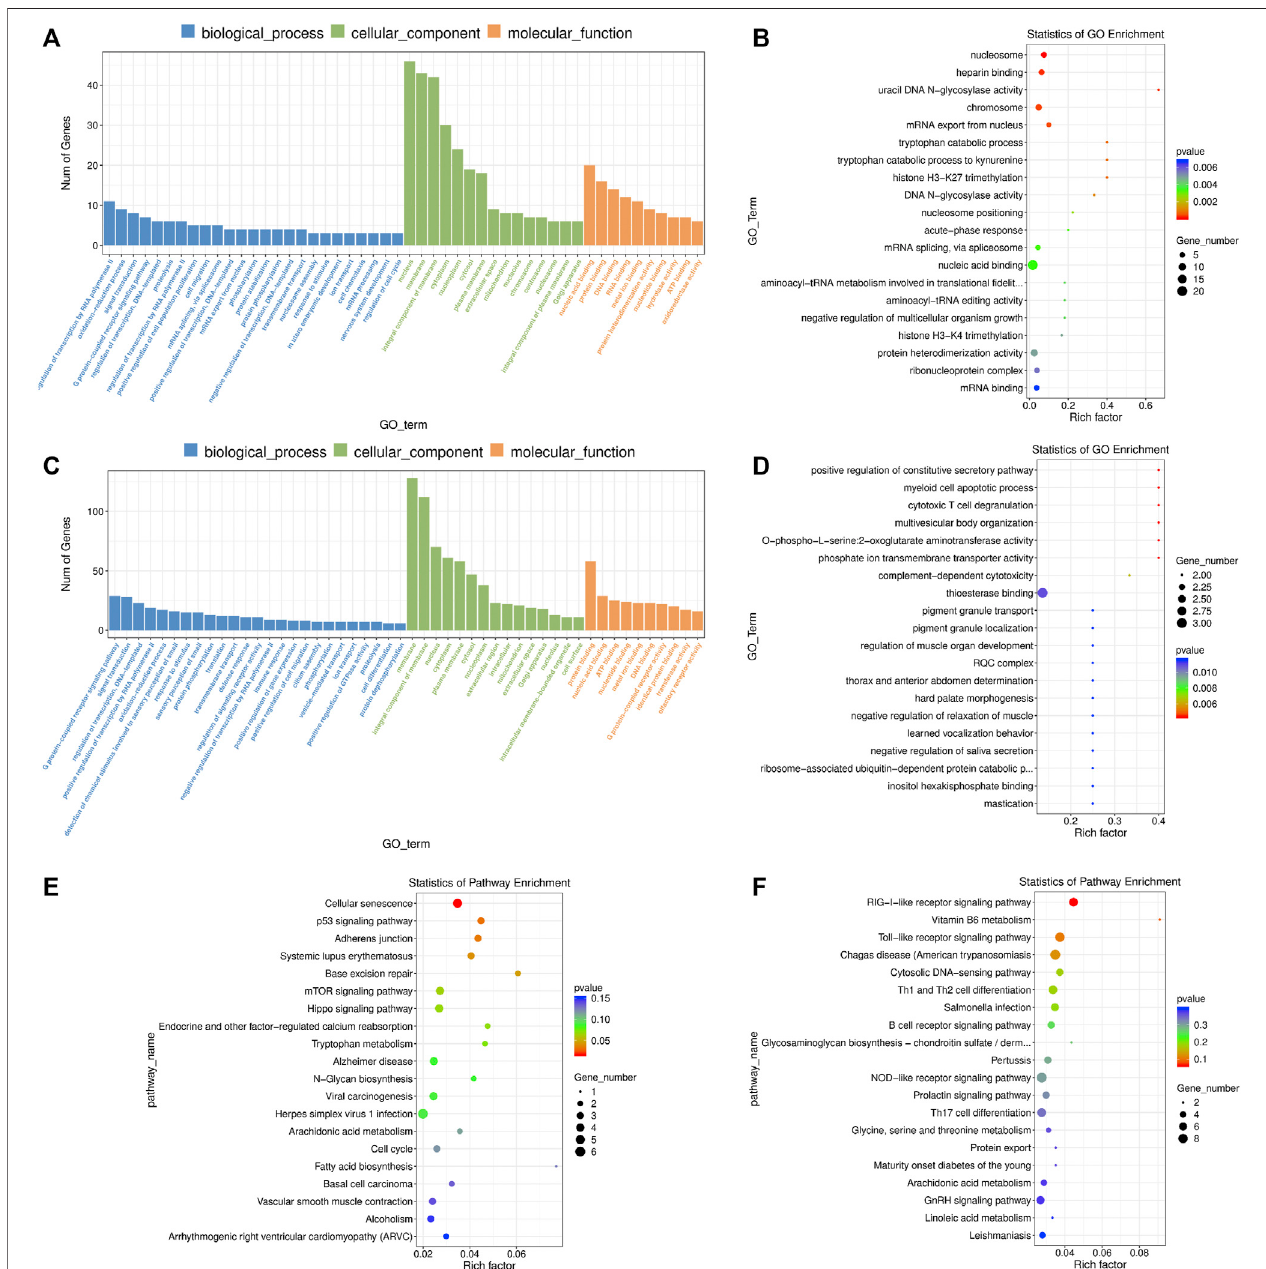
FIGURE 5 | GO and KEGG enrichment analysis ofdifferentially expressed (DE) mRNAs and lncRNA targets in 2-cells derived from vitri fi ed porcine cloned zygotes. (A) Histogramand (B) scatterplotofGOenrichmentforDEmRNAs; (C) histogramand (D) scatterplotofGOenrichmentfortargetgenesofDElncRNAs; (E) scatterplot of KEGG enrichment for DE mRNAs; (F) scatter plot of KEGG enrichment for target genes of DE lncRNAs.